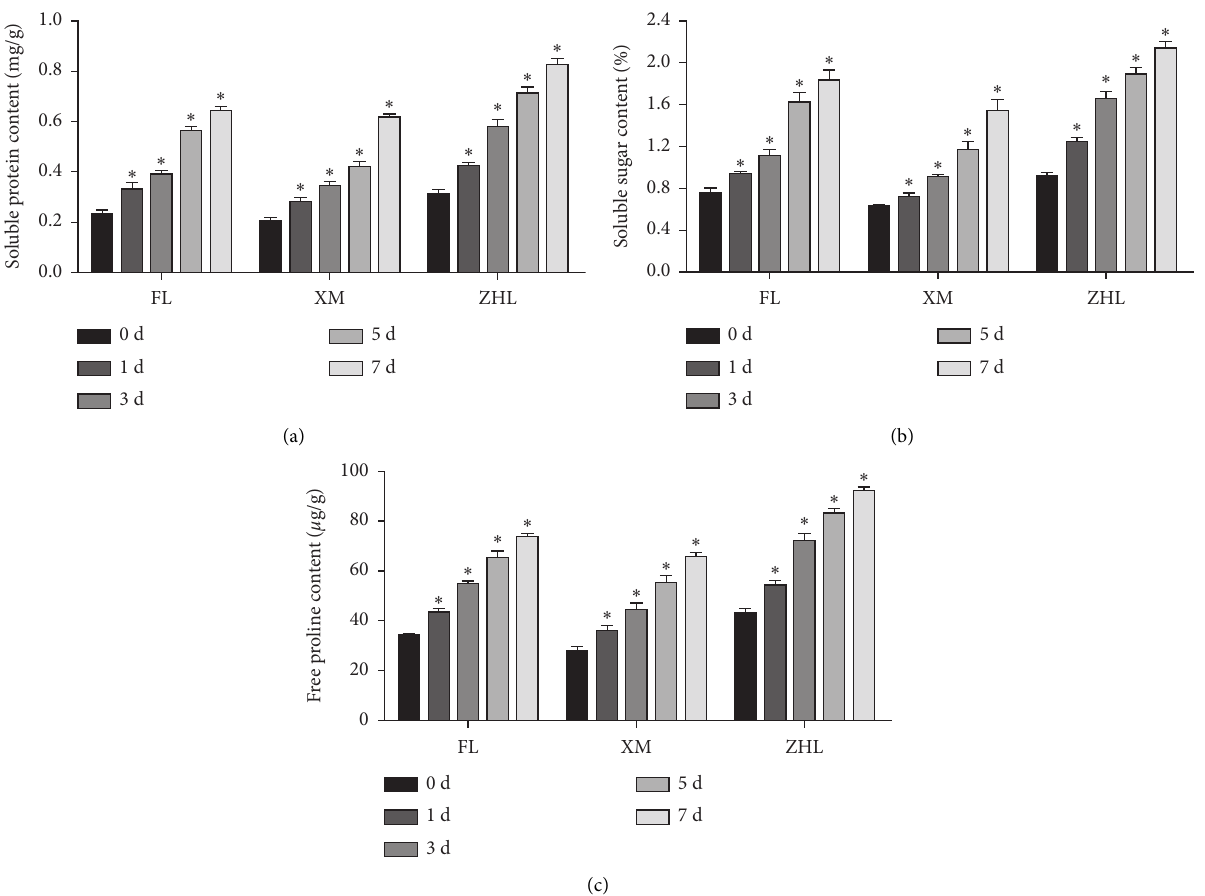
Figure 3: The changes of soluble protein content (a), soluble sugar content (b), and free proline content (c) of the annual branches of three varieties of pitaya with cold treatment. “ ∗ ” indicates the changes of soluble protein content, soluble sugar content, and free proline content with a significant difference at p < 0 . 05 compared with the control